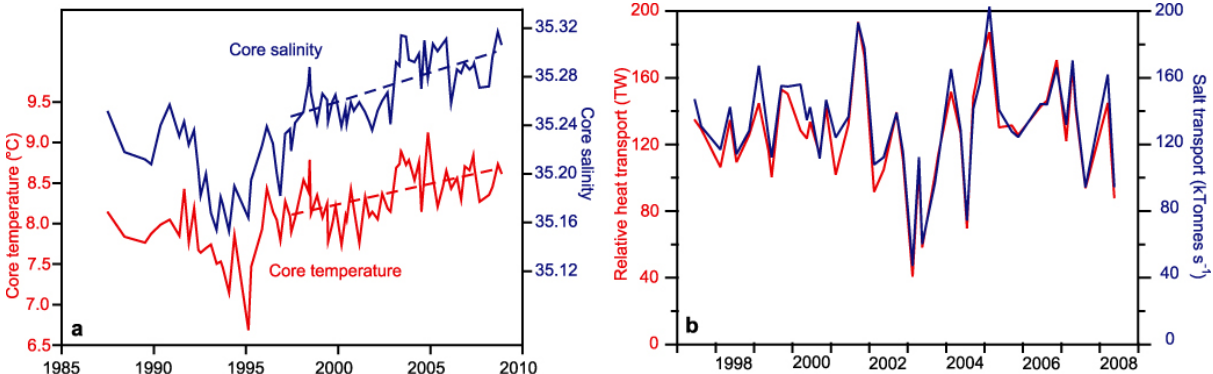
Fig. 4. (a) Temperature (red) and salinity (blue) in the core of the Faroe Current based on hydrographic surveys along the standard section. The typical seasonal variation was subtracted from the data before plotting. Broken lines indicate the trend from summer 1997 to summer 2008 based on linear regression. (b) Transport of relative heat (red) in TW (10 12 W) and salt (blue) in kTonnes s − 1 (10 6 kgs − 1